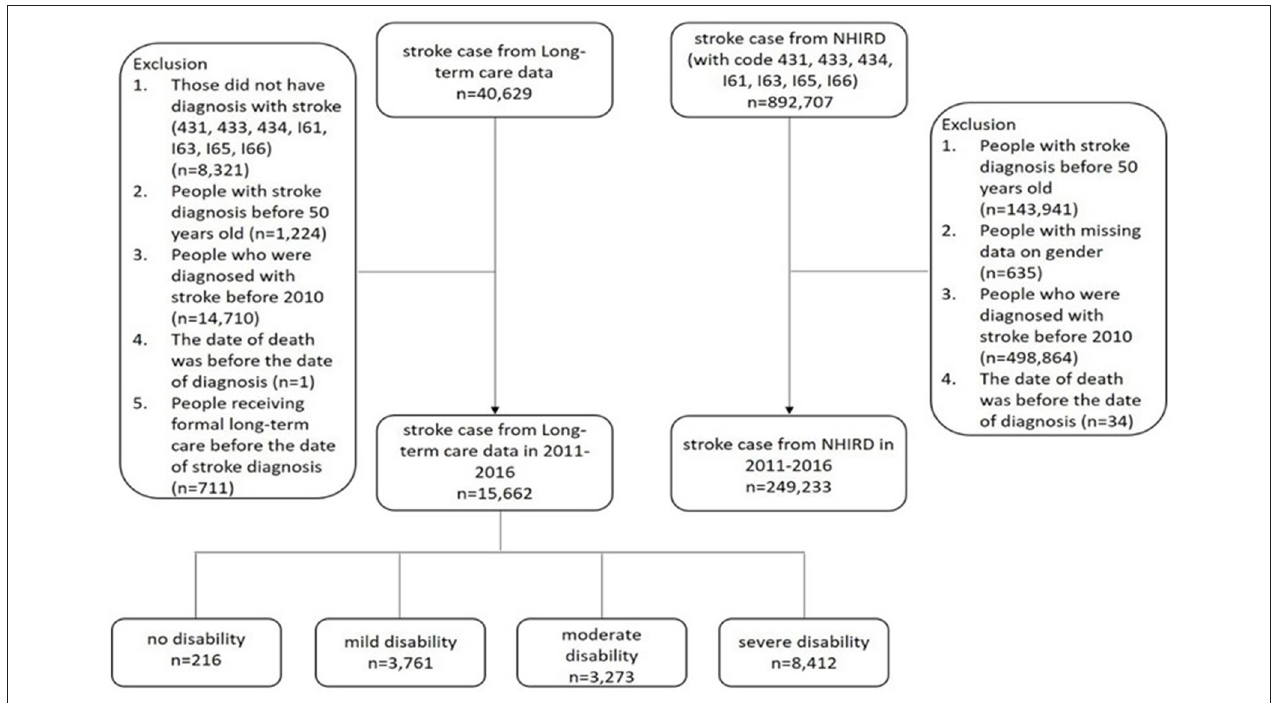
FIGURE 1 | Flow chart of the study